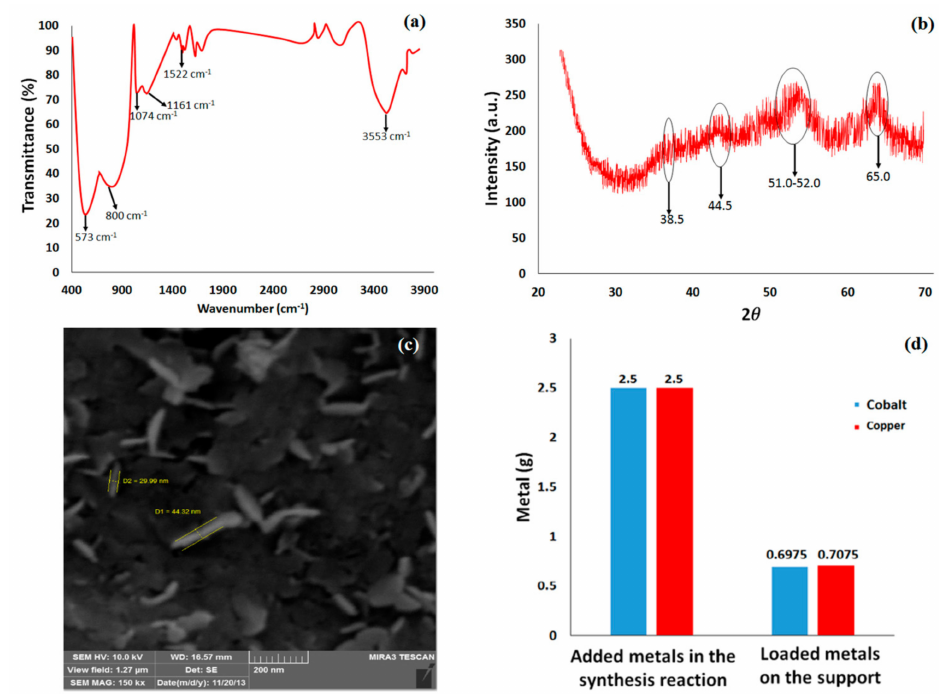
Figure 3. FT-IR spectrum ( a ); XRD pattern ( b ); SEM image ( c ); and ICP analysis ( d ) of the synthesized nanocatalyst.